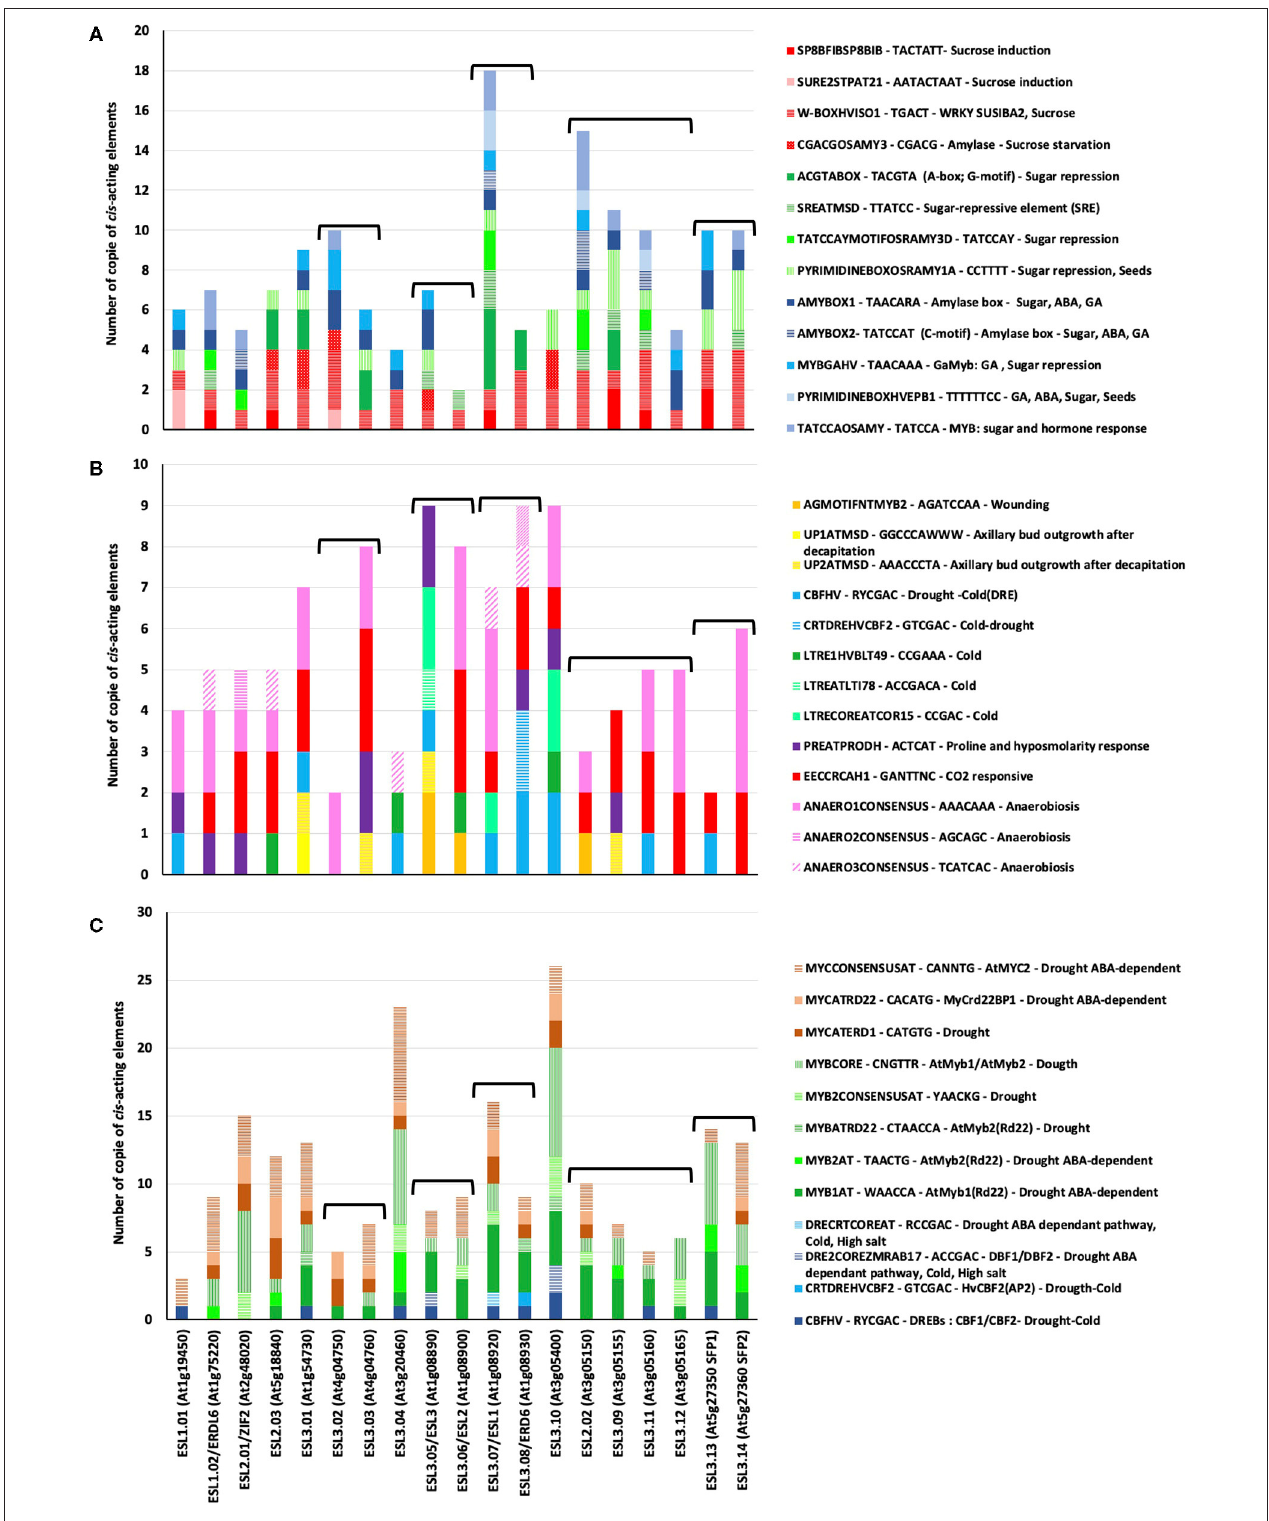
FIGURE 13 | Sugar and stress Cis -regulatory elements found in the 1-kb promoter of Arabidopsis thaliana ESL genes. (A) Cis -elements involved in sugar regulation. (B) Cis -elements involved in abiotic stresses response. (C) Cis -elements involved in drought response.